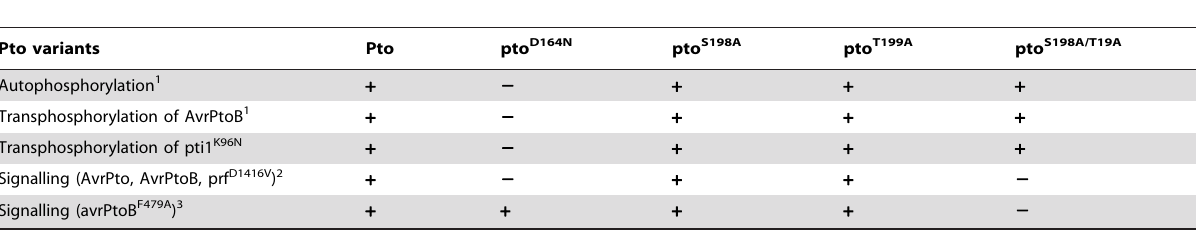
1 From Figure S6. 2 From Figure 2A. 3 From Figure S7. doi:10.1371/journal.ppat.1003123.t002 PLOS Pathogens |